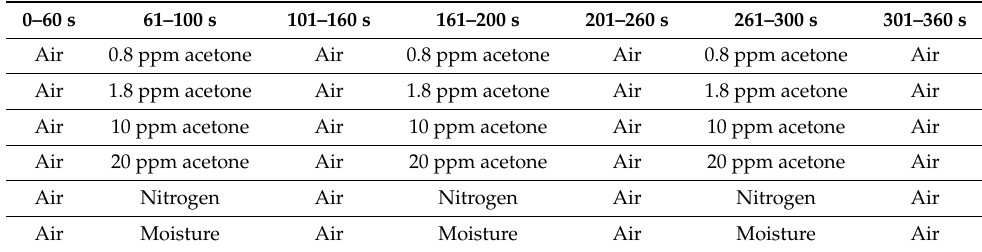
Table 1. The different gas concentrations corresponding to the different cycles in the experiments.